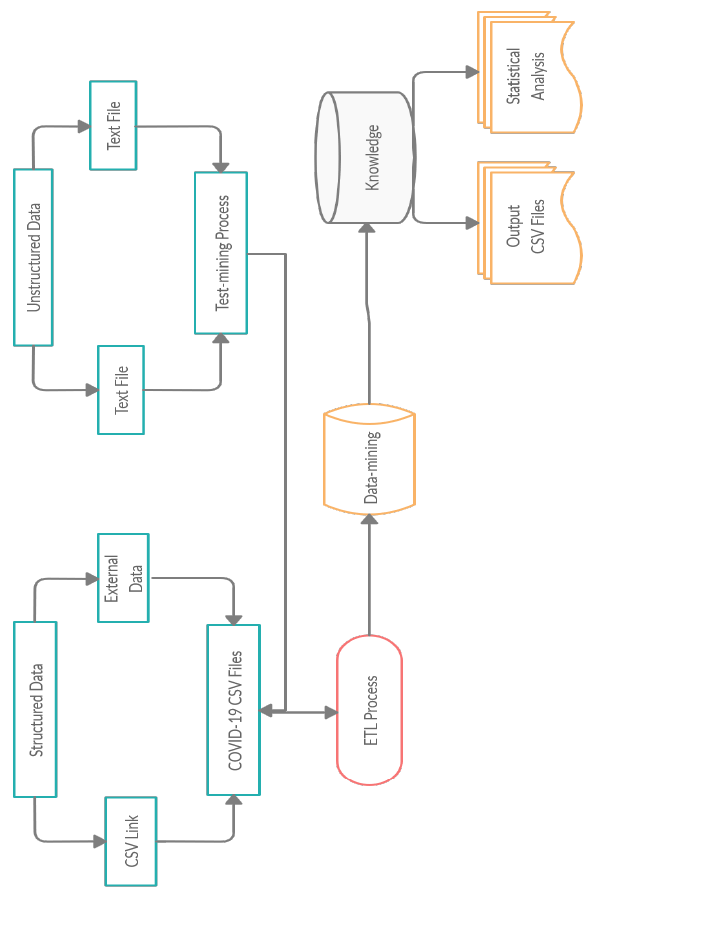
Figure 2. Research Methodology. Figure 3. Preprocessing of data in